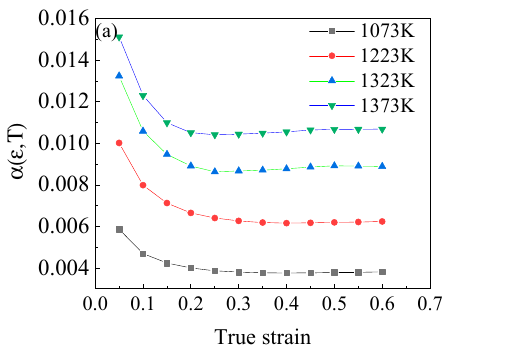
Figure 11. The value of α ( ε ,T) under different deformation conditions: ( a ) the experimental results, ( b ) the fitting results.